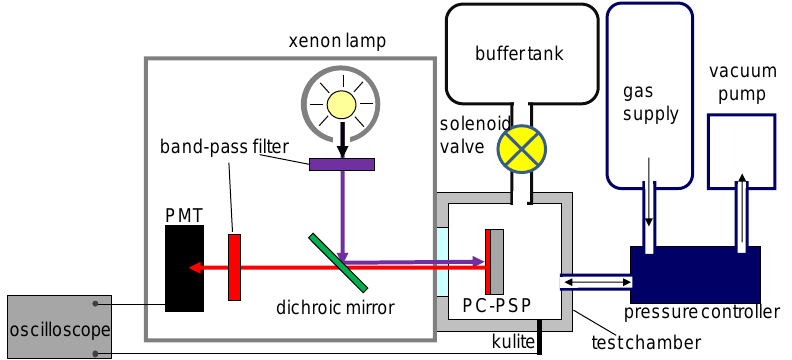
Figure 3. Schematic description of the unsteady-state calibration